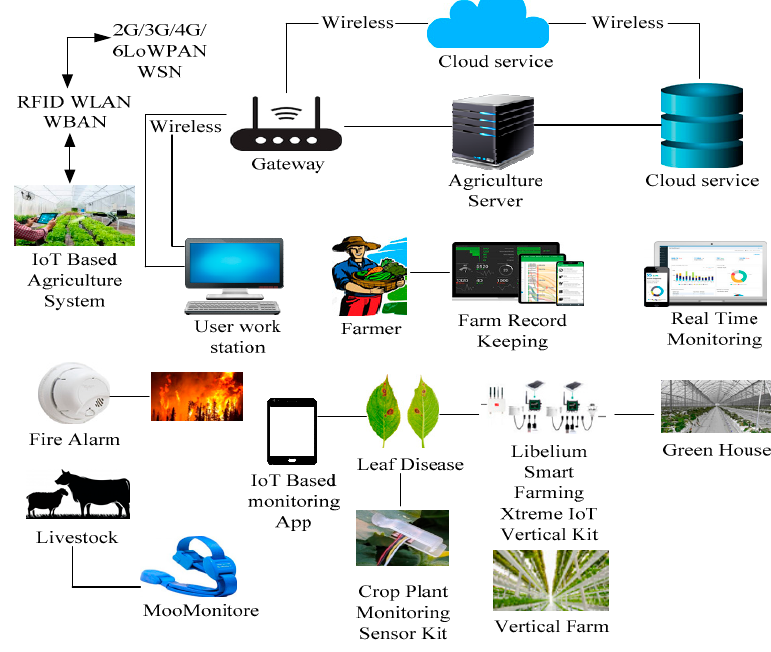
Figure 13. Smart farming